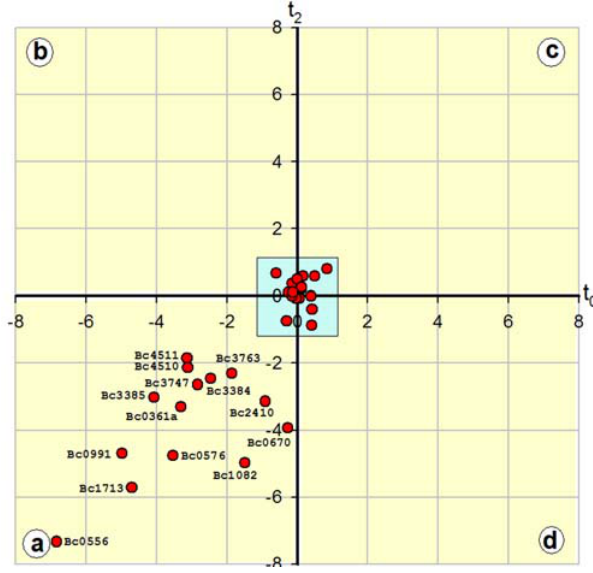
Figure 2. D plcR-wt expression ratios as determined by lacZ fusions. Ratios of expression between the wildtype strain and the delta plcR strain as determined by lacZ fusions. The log2 of these ratios were plotted at t 2 vs t 0 . Each red circle represents the values obtained for one gene. Inside the blue square at the center of the figure are the genes for which the expression ratios were equal or less than 2. The transcription of all the other genes was induced by PlcR both at t 0 and at t 2 (yellow square ‘a’).